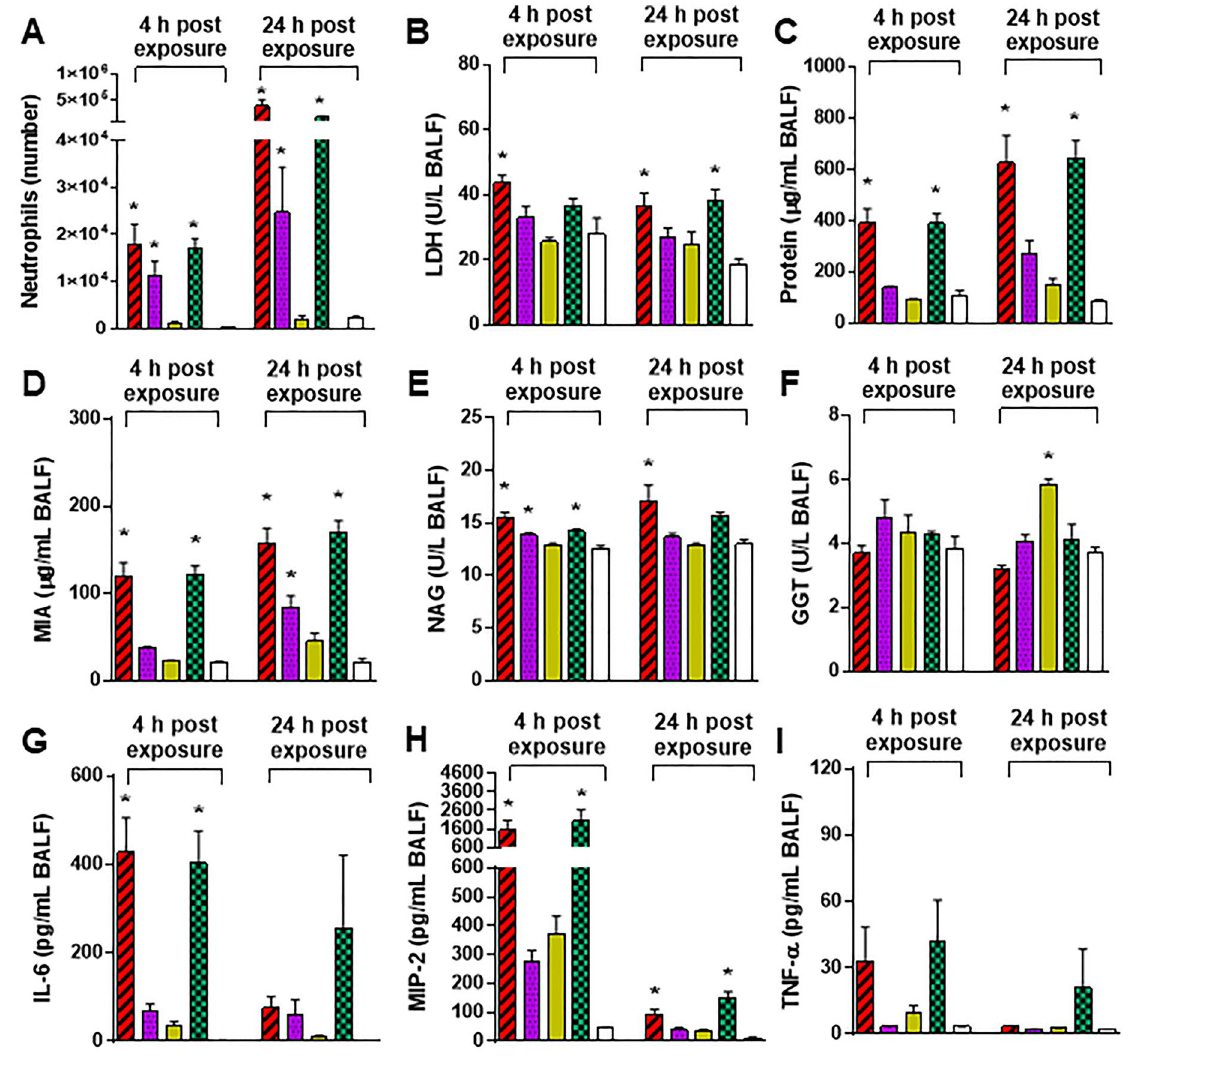
Figure 6. Lung toxicity of mice exposed to the rifle smoke PM, water-soluble components, water-soluble components without metal ions (low-metal), and water-insoluble components. ( A ) Neutrophil numbers, ( B ) LDH levels, ( C ) Protein levels, ( D ) Micro albumin levels, ( E ) NAG levels, ( F ) GGT levels, ( G ) IL-6 levels, ( H ) MIP-2 levels, ( I ) TNF-α levels. Mice were exposed to the PM (20 µg) by oropharyngeal aspiration and BALF was obtained at 4 and 24 h post exposure. Data are mean ± SEM obtained from 6 mice for each group. *p < 0.05 compared with saline-exposed group (a negative control) from the same time point (one-way ANOVA with post-hoc Dunnett’s